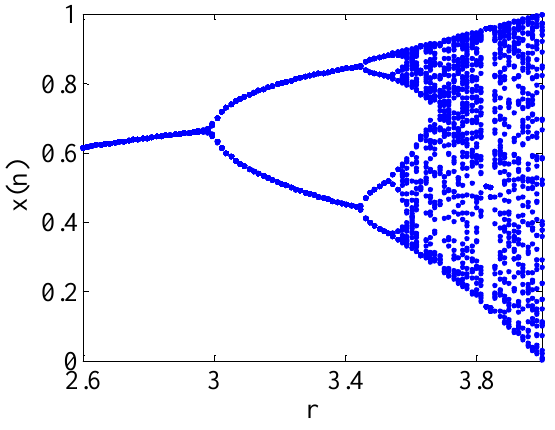
Figure 1. Logistic map.